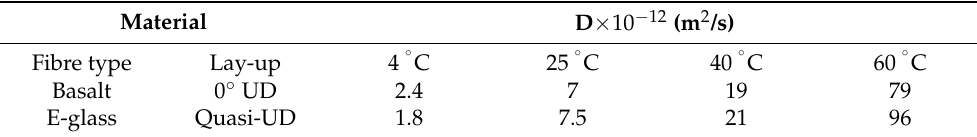
Table 5. An overview of the variation in moisture absorption capacity, 𝑀 ∞ . data obtained from the literature when different types of reinforcement, epoxy resin, manufacturing technology and con- ditioning environment has been used (PW- Plain-woven, NCF — Non-crimp fabric, UD — Unidirec- tional)